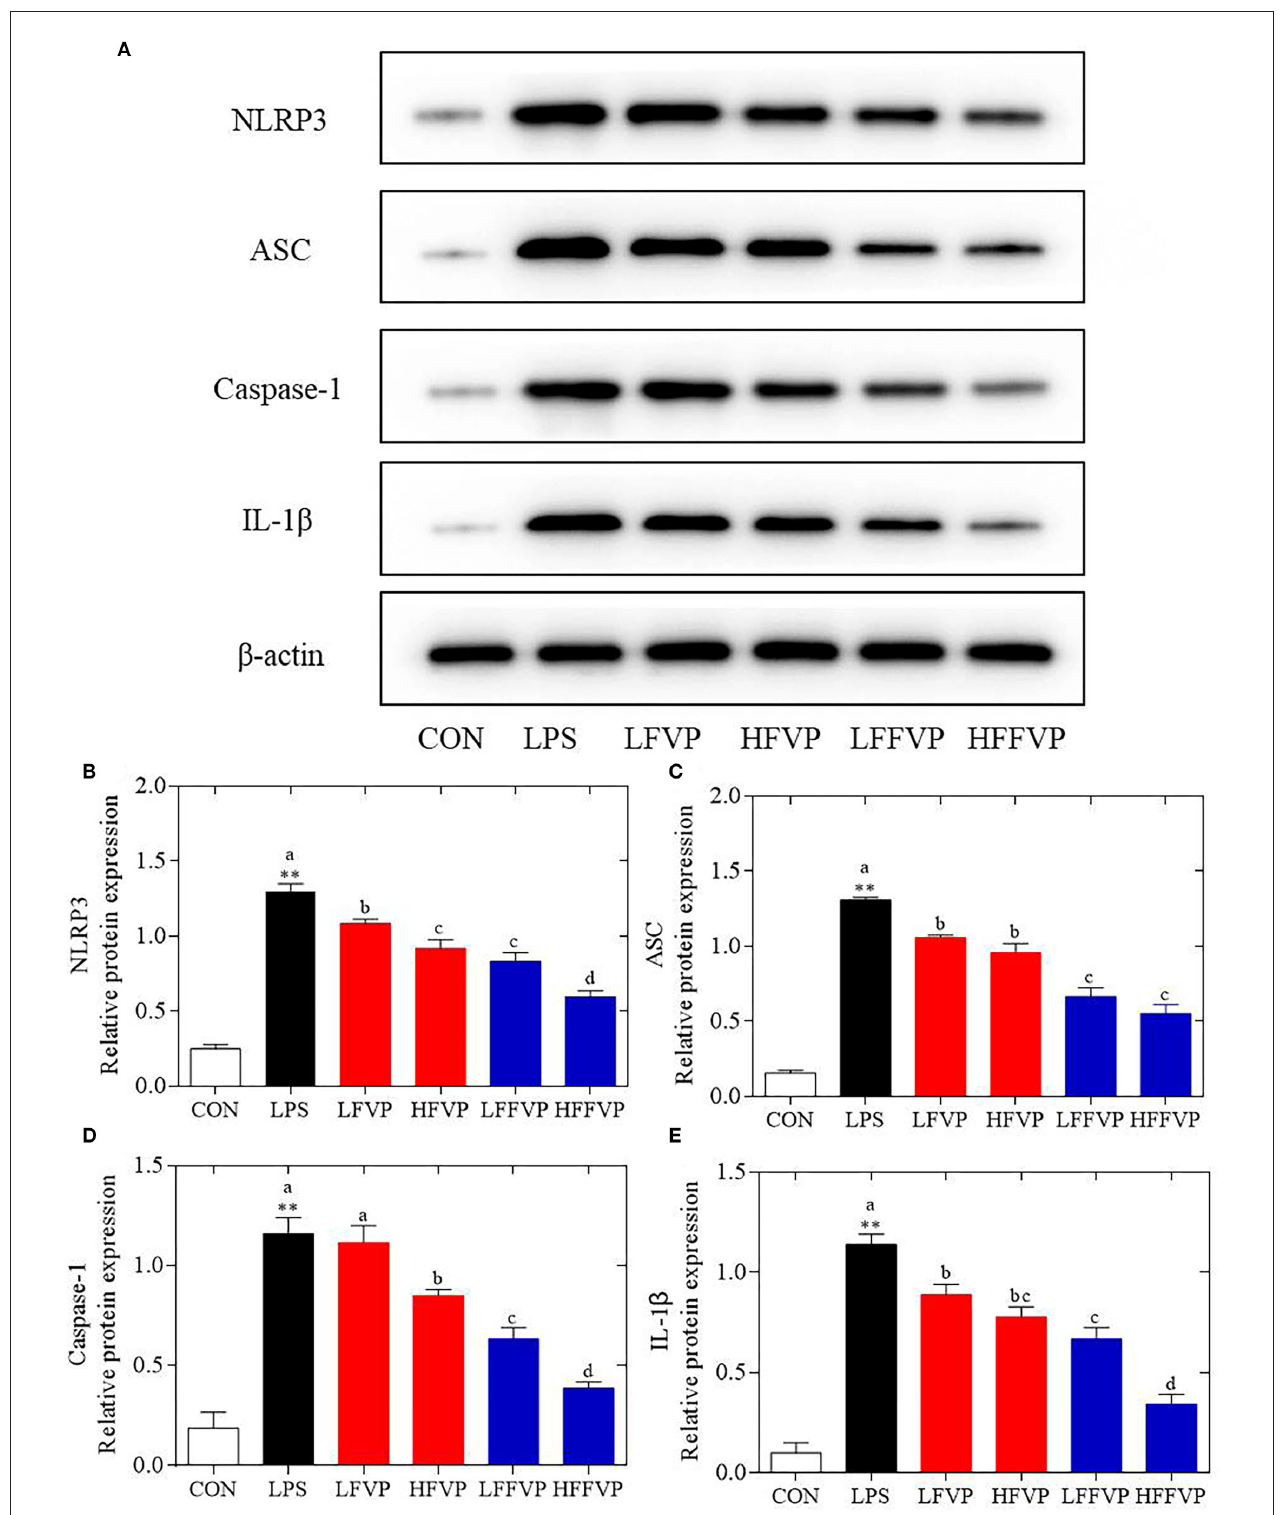
FIGURE 5 | LPS-induced NLRP3/ β -actin (A,B) , ASC/ β -actin (A,C) , Caspase-1/ β -actin (A,D) and IL-1 β / β -actin (A,E) protein expression treated by FVP and FFVP. FV, Flammulina velutipes ; FVP, Flammulina velutipes polysaccharides; CON, control group; LPS, lipopolysaccharide; LFVP, low dose FVP group; HFVP, high dose FVP group; LFFVP, low dose FFVP group; HFFVP, high dose FFVP group. ** P < 0.01 represents LPS vs. CON group; a, b and c ( P < 0.05) represent FVP and FFVP groups vs. LPS treated mice.